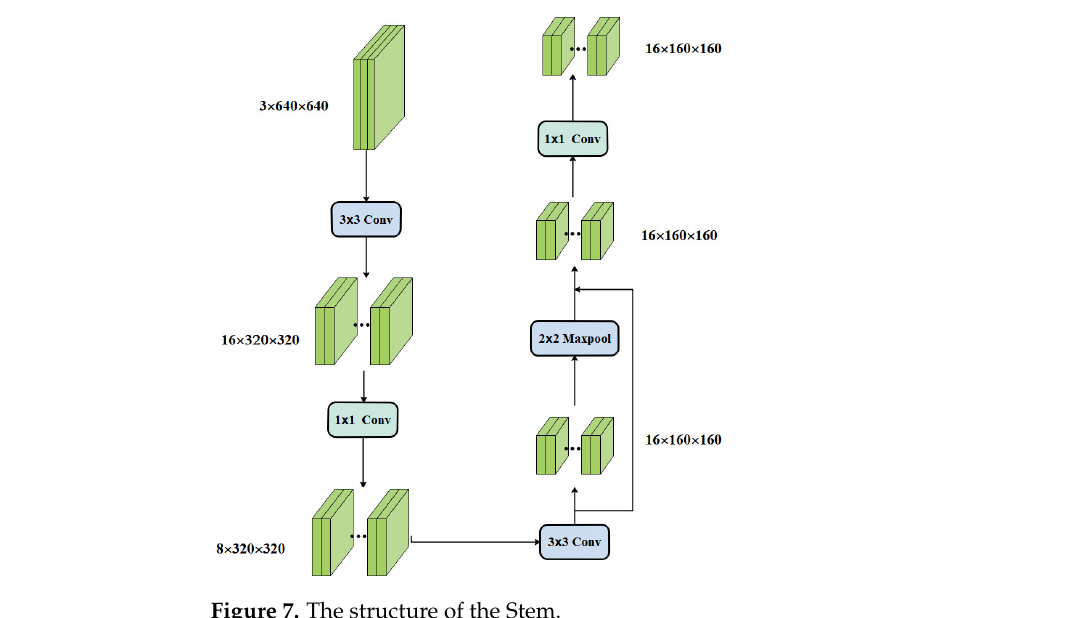
Figure 7. The structure of the Stem.